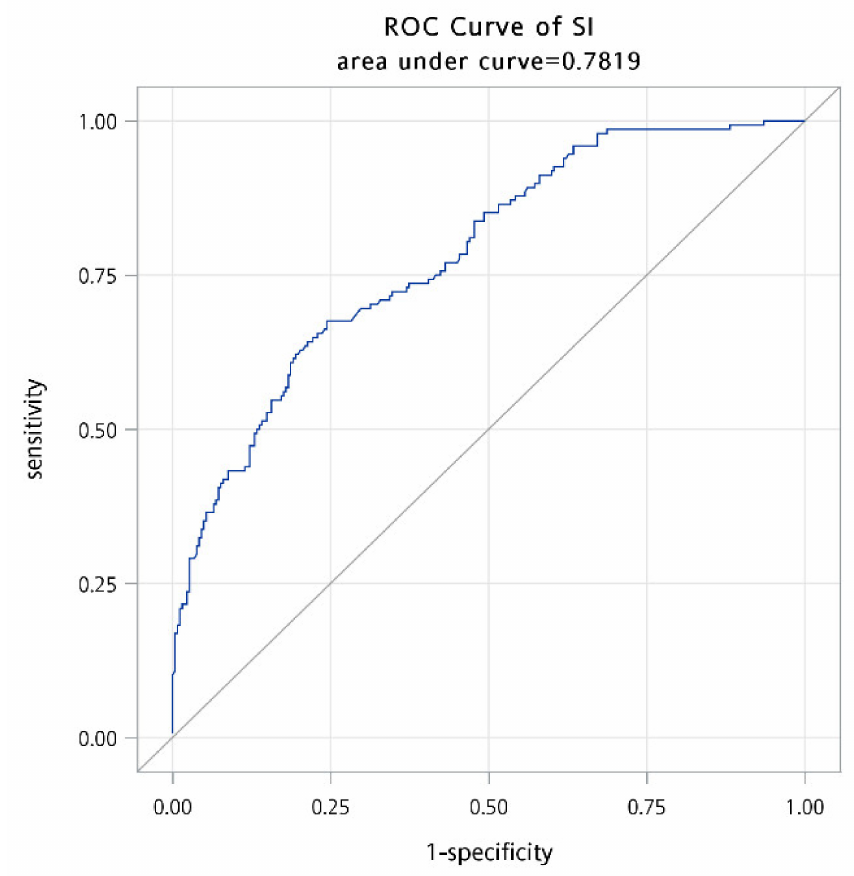
Figure 1. Receiver operating characteristic curve of Shock Index in predicting 60-day mortality.